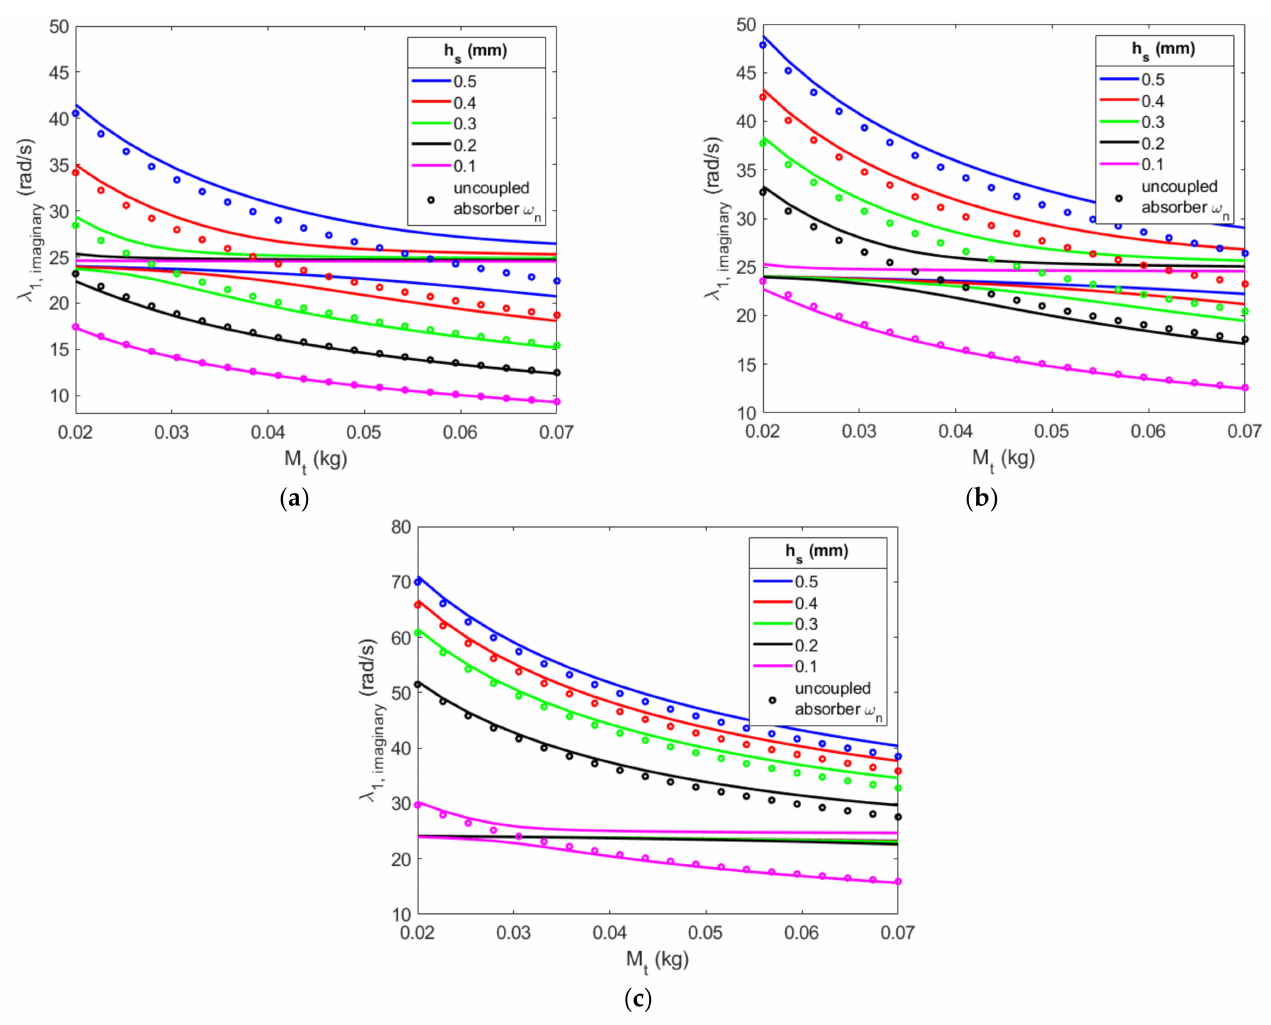
Figure A1. Tip mass effects on the coupled natural frequencies with various substrate thicknesses for an initial gap size of ( a ) 10 mm, ( b ) 7.5 mm and ( c ) 5